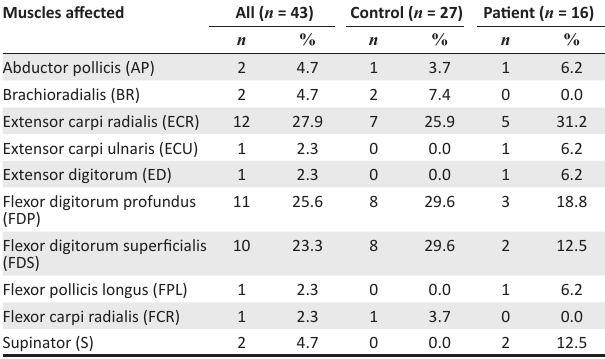
TABLE 5: Post:pre-exercise signal intensity ratio measurements. Post:pre-exercise SIR All participants ( n = 43)